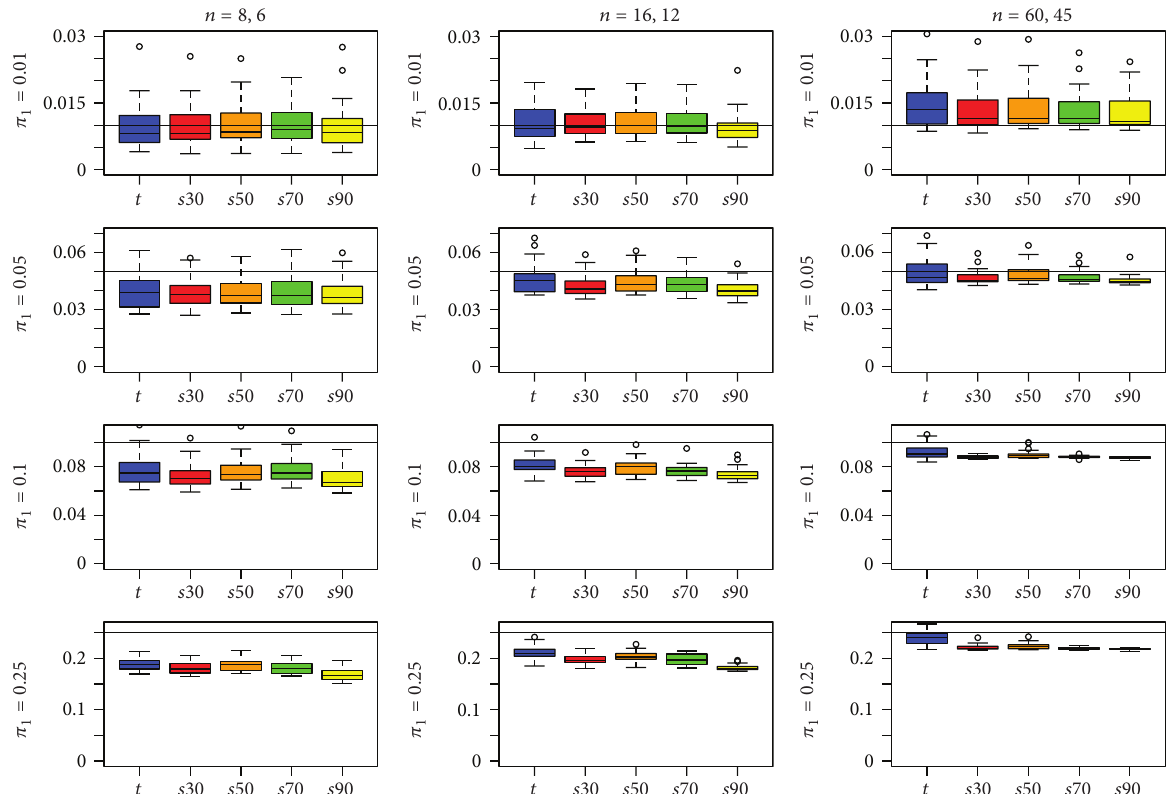
F 6: “convest” estimates of proportion of differentially expressed